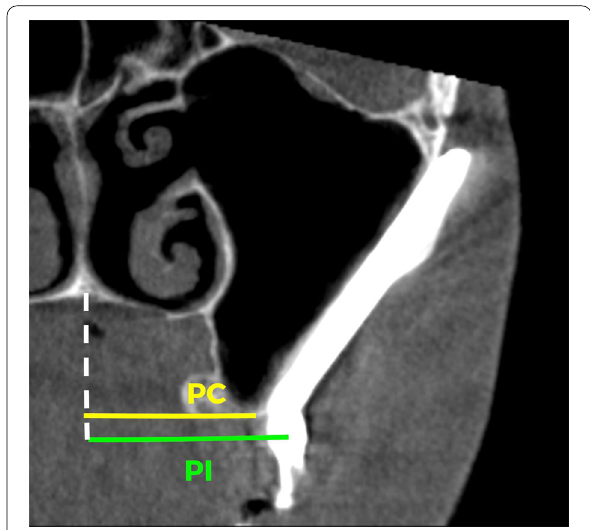
Fig. 6 Distance from the palate half‑way point to the crest midpoint (P–C) and distances from the palate half‑way point to each implant